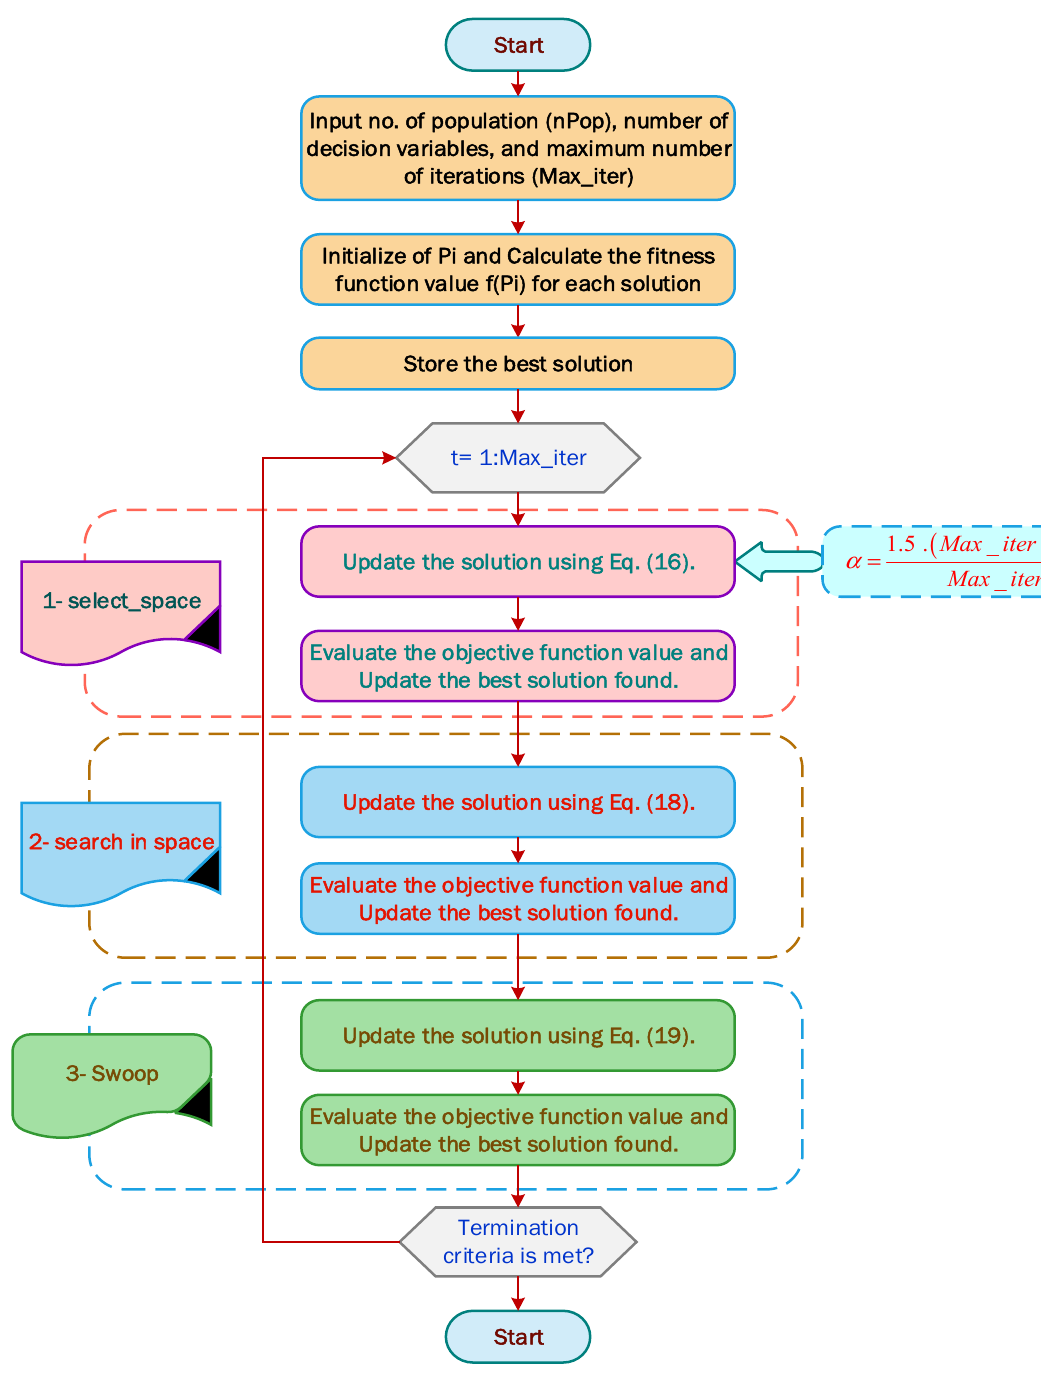
Figure 8. Flowchart for the IBES algorithm.